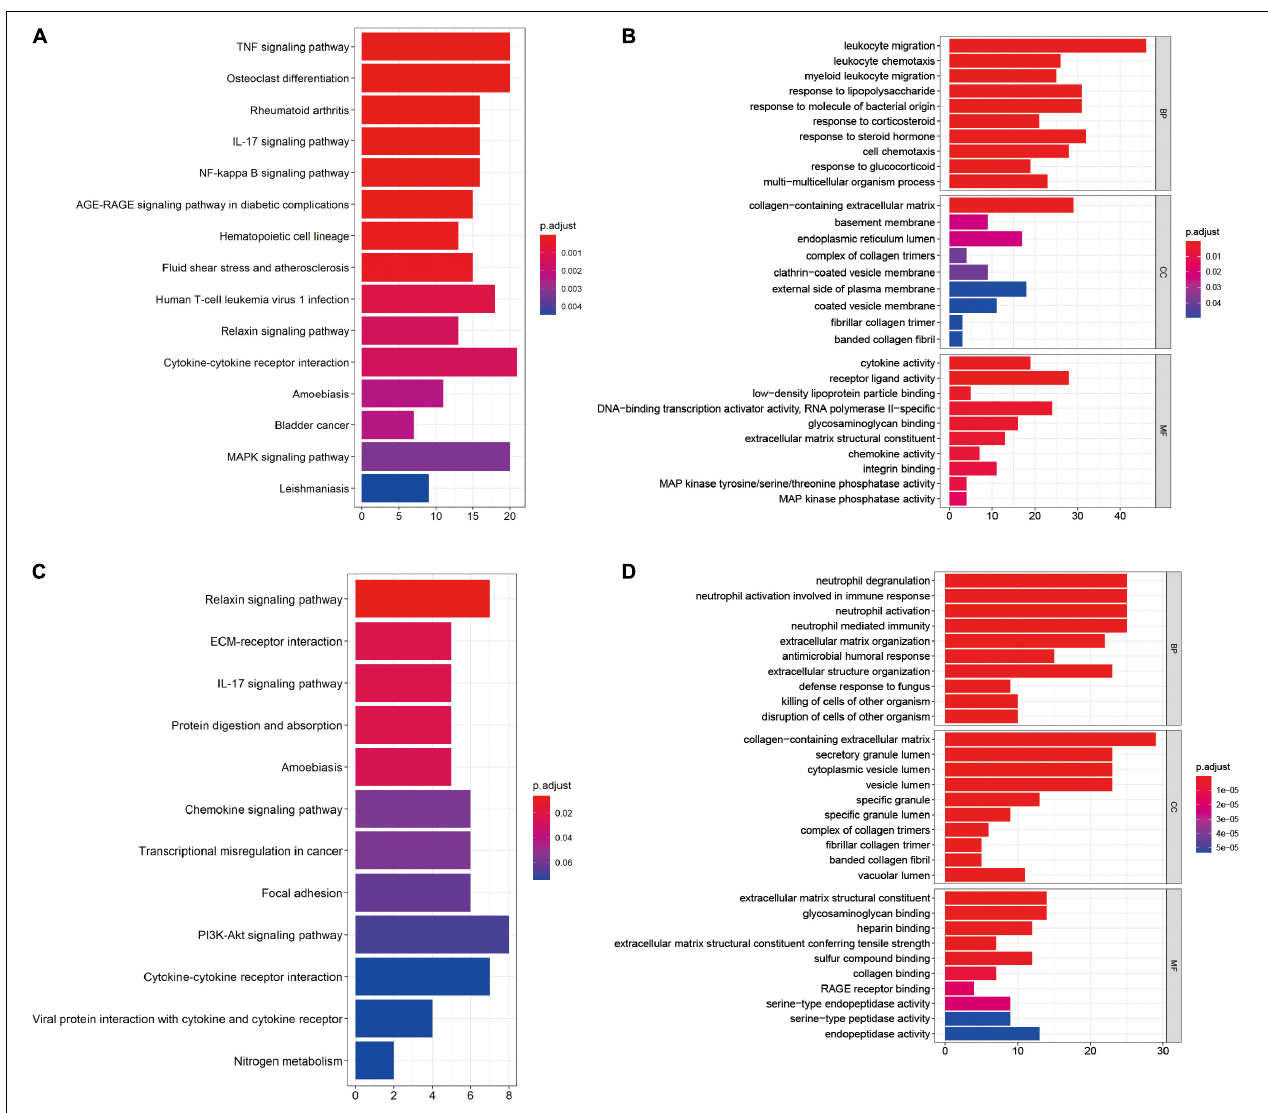
FIGURE 2 | Functional enrichment of the differentially expressed genes (DEGs) in the synovial membrane and cartilage samples. (A,B) Kyoto Encyclopedia of Genes and Genomes (KEGG) pathway enrichment and Gene Ontology (GO) analysis of the DEGs in synovial membrane samples. (C,D) KEGG pathway enrichment and GO analysis of the DEGs in cartilage